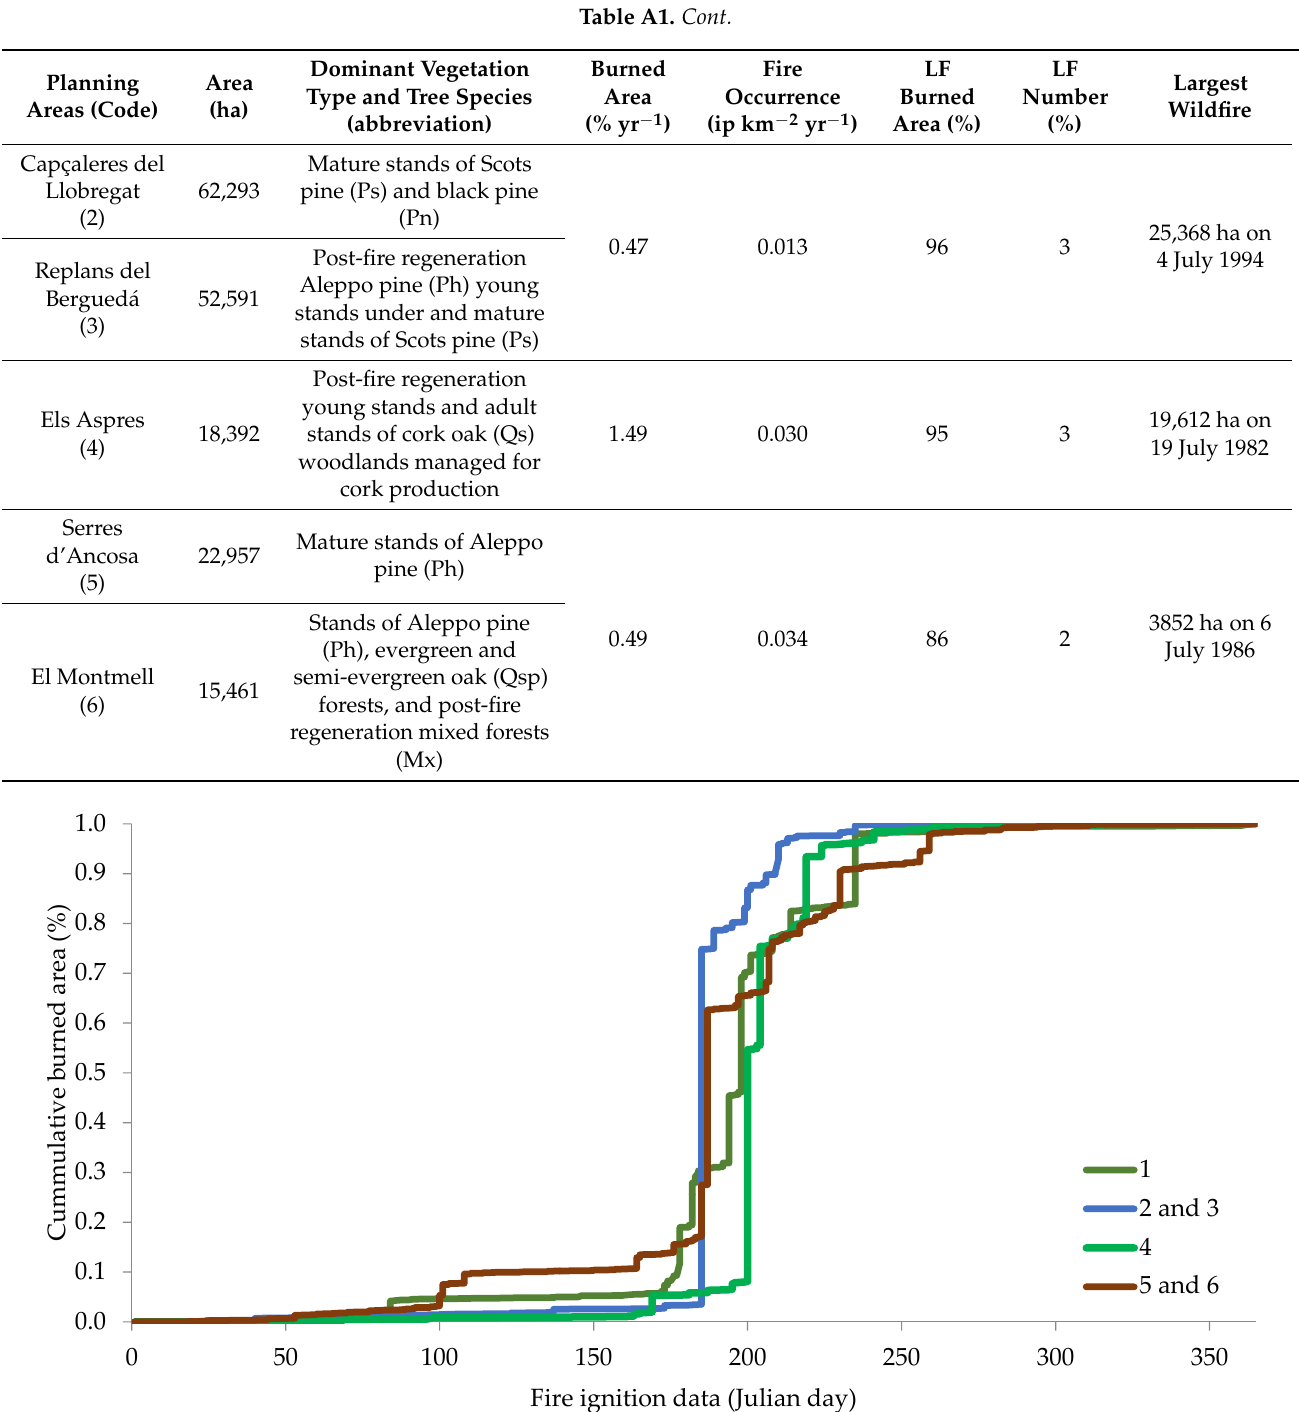
Figure A1. Daily cumulative burned area for the different fire modeling domains. The wildfire season went from 25 June to 23 August in planning area 1, 4 July to 30 July in planning area 2 and planning area 3, 18 June to 13 August in planning area 4, and 10 April to 12 September in planning area 5 and planning area 6.